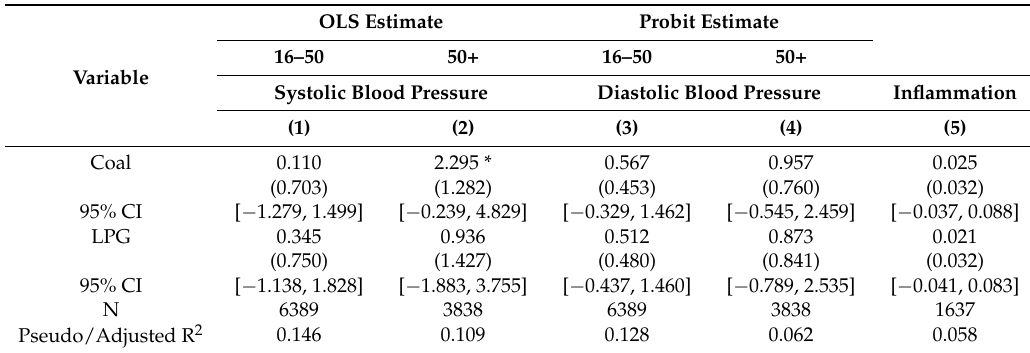
Table 6. OLS/probit estimates for the effect of household cooking fuels on women’s blood pressure/inflammation in rural areas: CHNS.